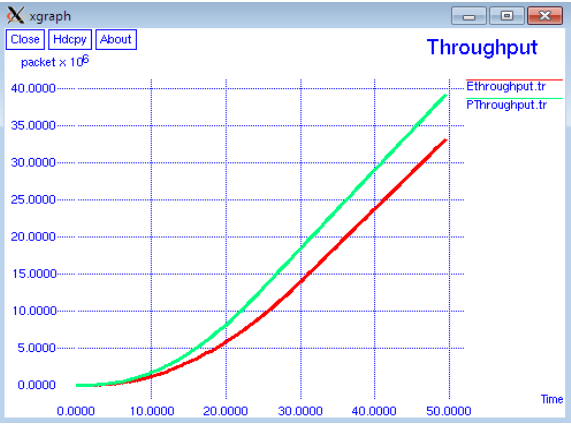
Figure. 4 Throughput for location